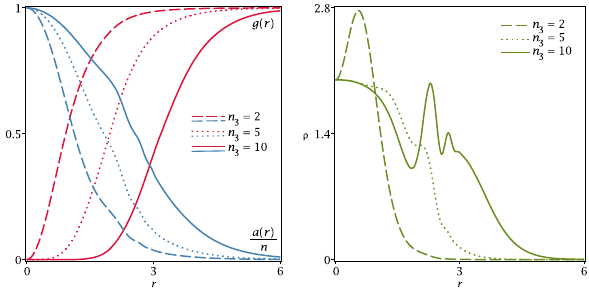
Fig. 13 Solutions of (18) for generalized permeabilities μ 1 = 1, μ 2 = | ϕ | 2 and μ 1 3 givenbyEq.(30).Intheleft,wedepicttheprofilesof g 3 (red) and a 3 ( r ) (blue). In the right, we show the corresponding energy densities ρ 3 ( r ) . Here, n 1 = 1, n 2 = 10 and n 3 takes the values 2, 5 and